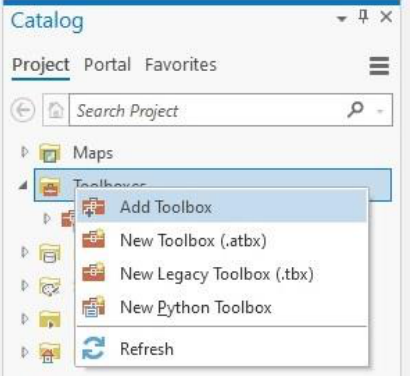
Figure A3. Three geoprocessing tools that appear within the Water Yield Estimation toolbox. Basal Area to LAI: This tool can be used to convert a pine-specific basal area raster, with units in square feet per acre, to LAI. The conversion of basal area (BA) from imperial to metric multiplies the BA value by 0.229568411, and then uses Equation 2 for final conversion to LAI. The output basal area raster (ba_m2ha.tif in Figure A4) will be needed if the “Scenario Water Yield Calculation” tool will be used. Howev er, if BA product already has metric units, do not utilize this tool. Equation (2) may be used in the standard raster calculator.